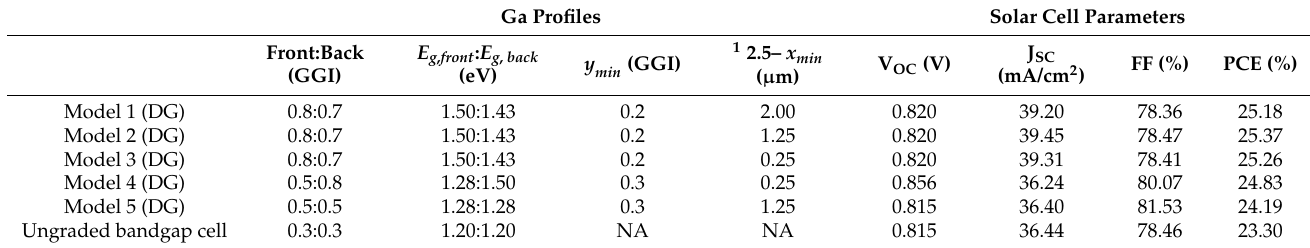
Figure 8. ( a ) Different Ga profiles implemented in the simulations in order to extract the most suitable front and back grading profiles for double graded (DG) bandgap structure. These Ga profiles show the compositional ratio GGI along the CIGS layer depth; ( b ) simulated J-V curves obtained using the different compositional ratio as reported in SRH and radiative recombination profiles left inset. Table 7. Solar Cell Parameters For Different Front and Double Grading Combinations Extracted from Simulated J-V Reported in SRH and Radiative Recombination Profiles (Left Inset).